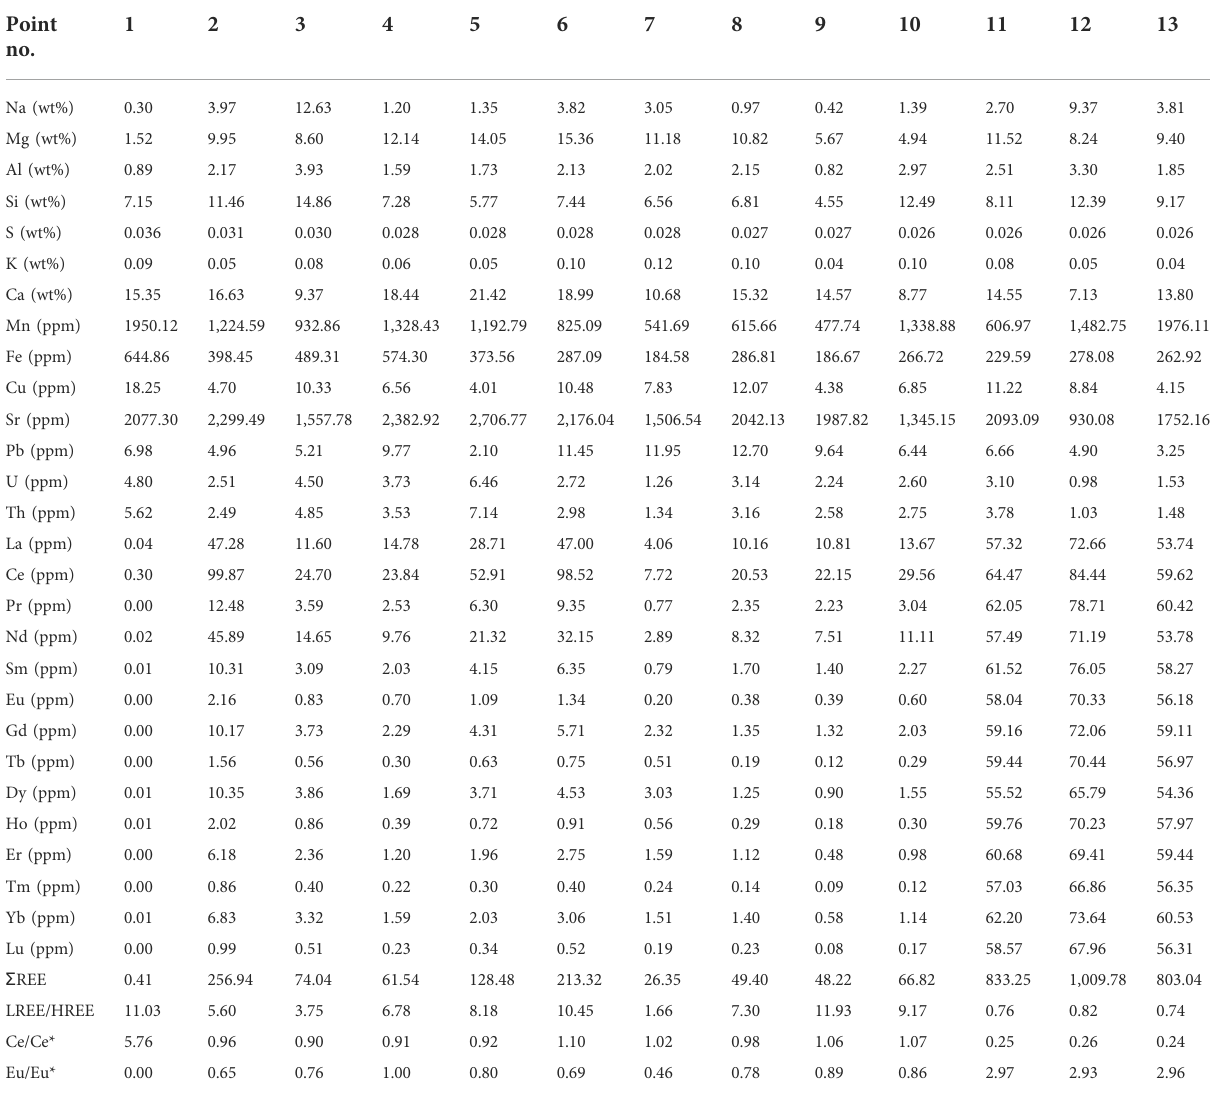
TABLE 1 Elemental composition determined using the LA-ICP-MS analysis. Point